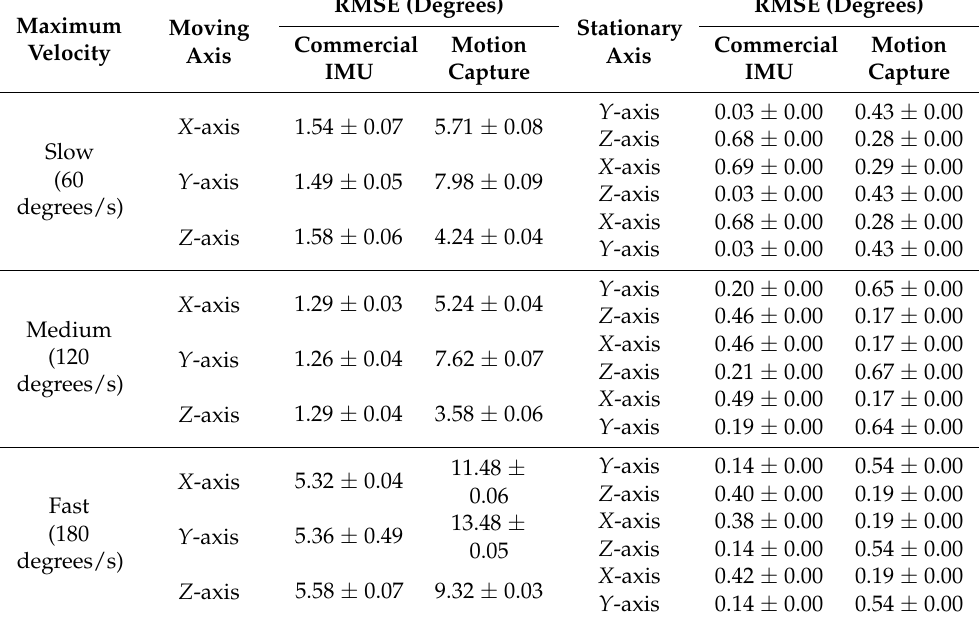
Table 3. Accuracy and repeatability results for the sinusoidal movement profile. Shown is the root-mean-square error (RMSE) for the three different movement axes and three different movement velocities: 60 degrees/s, 120 degrees/s, and 180